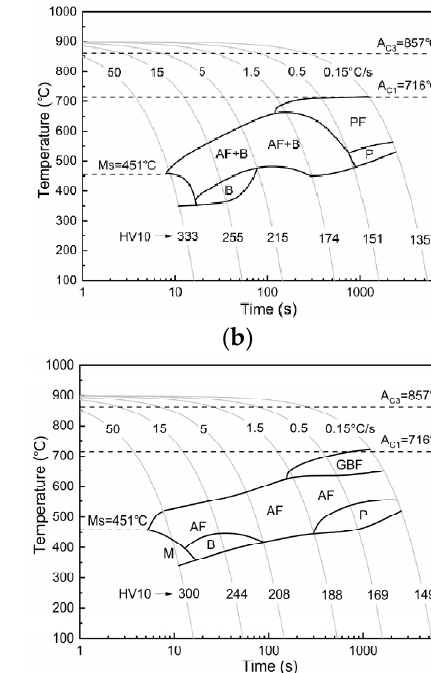
Figure 1. Schematic diagrams of thermal treatment processes for ( a ) continuous cooling transformation, ( b ) in situ observation and ( c ) austenitization holding.